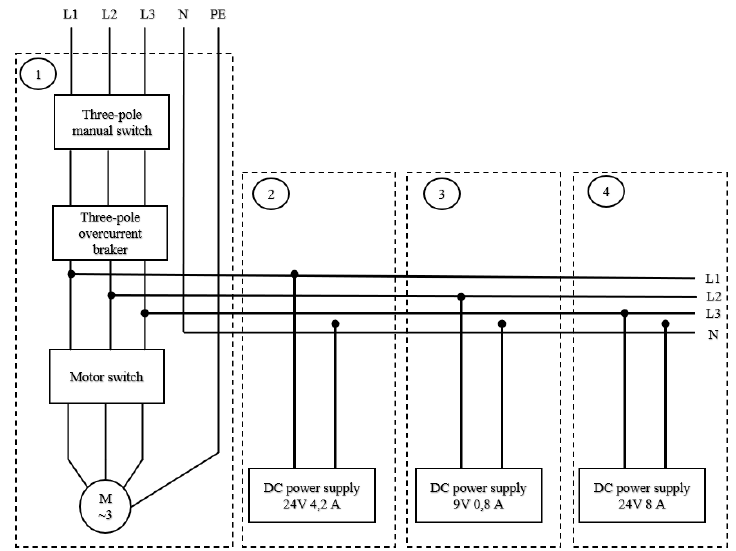
Figure 5. Block diagram of electrical subsystem.